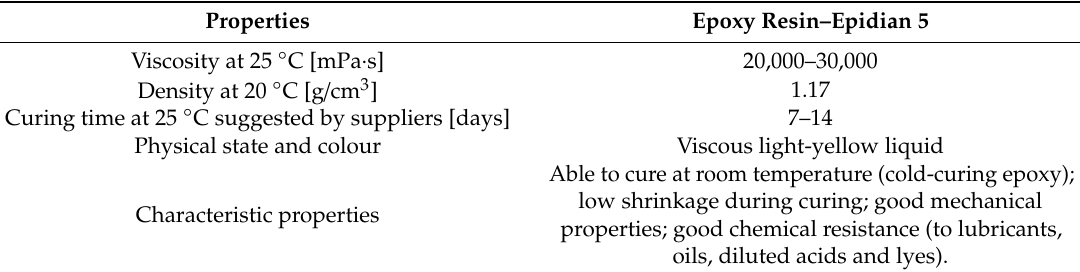
Table 1. Epoxy resin properties.